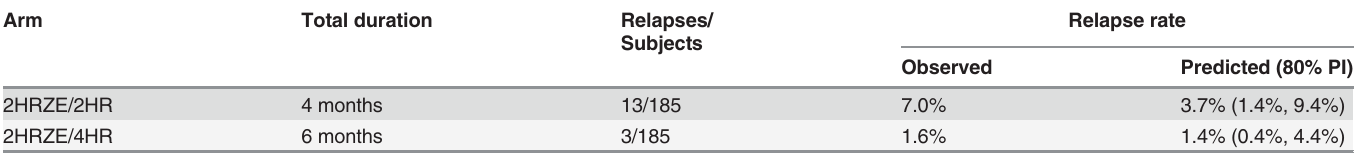
Table 5. Observed and predicted relapse rates in the treatment shortening study of Johnson et al